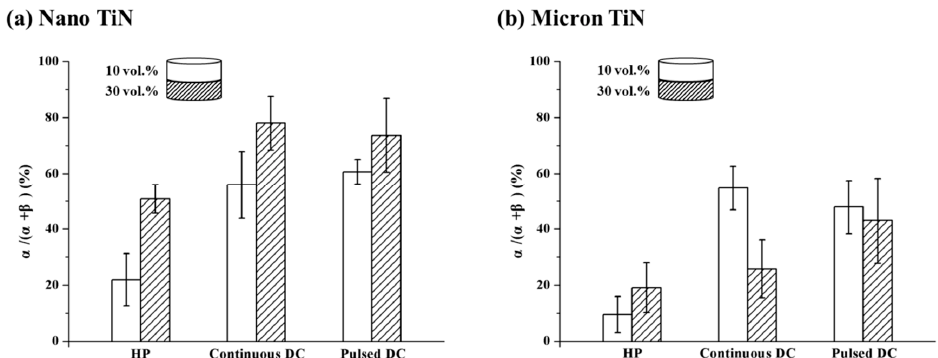
Figure 9. The α -Si 3 N 4 fraction of each layer within the double-layered Si 3 N 4 –TiN composites with ( a ) nano-sized TiN and ( b ) micron-sized TiN, prepared at 1700 ◦ C for 5 min by using di ff erent sintering methods. Each layer contains di ff erent TiN contents.